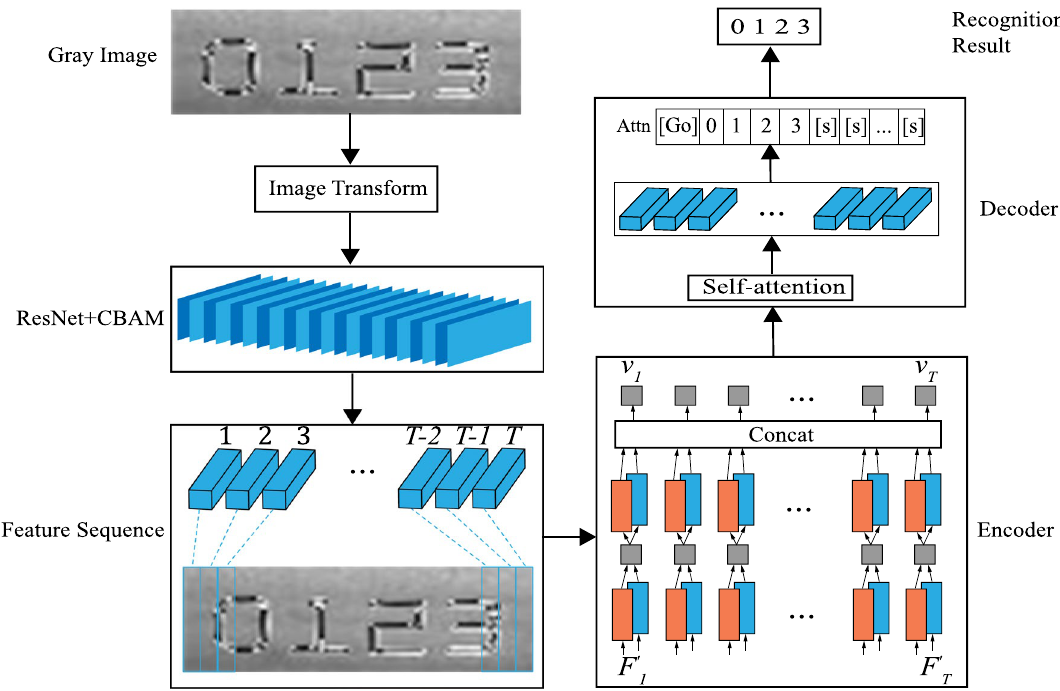
Fig. 2 End-to-end network structure of the proposed model